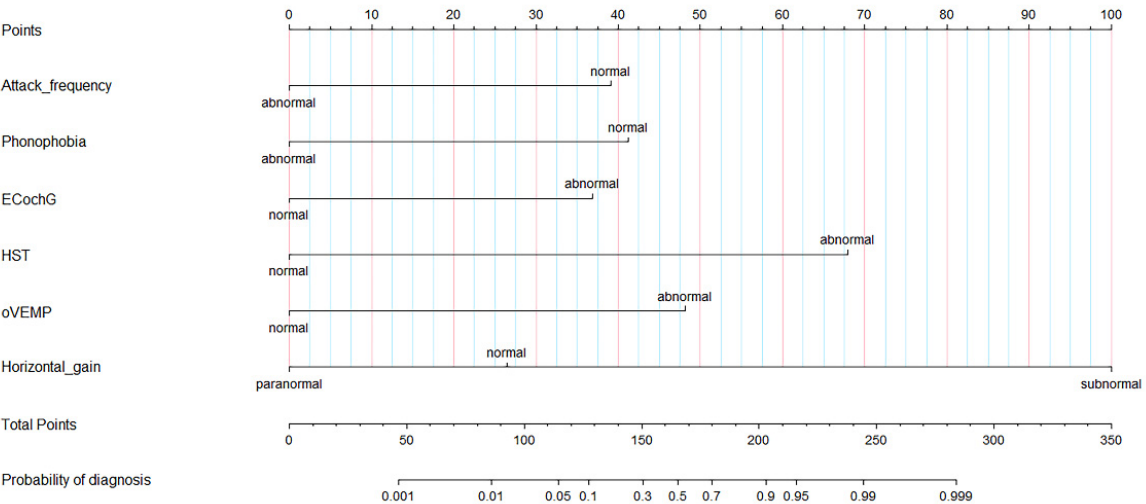
Figure 3. Diagnostic nomogram estimated by clinical and auditory-vestibular function features for patients with VM and MD. EcochG, electrocochleogram; HST, head shake test; o-VEMP, Ocular Vestibular Evoked Myogenic Potential; VM, vestibular migraine; MD, Meniere’s disease. The following method was used for the nomogram: (1) the patient-related values were input on the diagnostic variable axes. (2) An intersection line was drawn perpendic- ular to the score axis from the marked points of each variable axis to obtain the corre- sponding scores of each variable. (3) Finally, all scores were added, the corresponding points on the total score axis were determined, and a vertical line was drawn perpendic- ular to the probability axis from the six points on the total score axis. The value obtained from the intersection is the probability of differential diagnosis between VM and MD. 3.5. Internal Validation of the Prediction Model The development and validation of the predictive model was according to the re- quirements of the TRIPOD (Transparent Reporting of a multi-variable prediction model for Individual Prognosis or Diagnosis) Statement [17], an international guideline specifi- cally designed for diagnosis or prognosis. The prediction model needs the verification of samples in different periods, regions, and centers to truly reflect the real prediction effi- ciency [16]. Therefore, we prospectively collected the clinical data of new patients as the validation population of the center in different periods, verified the model, and evaluated its clinical application value. A total of 28 patients with VM and 28 patients with MD were prospectively recruited as the validation set. Moreover, there was no significant difference in clinical features between the model and the validation group ( p > 0.05). The internal validation was performed by evaluating the performance of the model with respect to its discriminative and calibrating ability. 3.6. Discriminative Power The area under the receiver operating characteristic curve (AUROC) is commonly used in clinical practice to quantify the predictive model discrimination power. In the two groups, ROC curves were plotted. In model group, AUROC was 0.982 (95% CI: